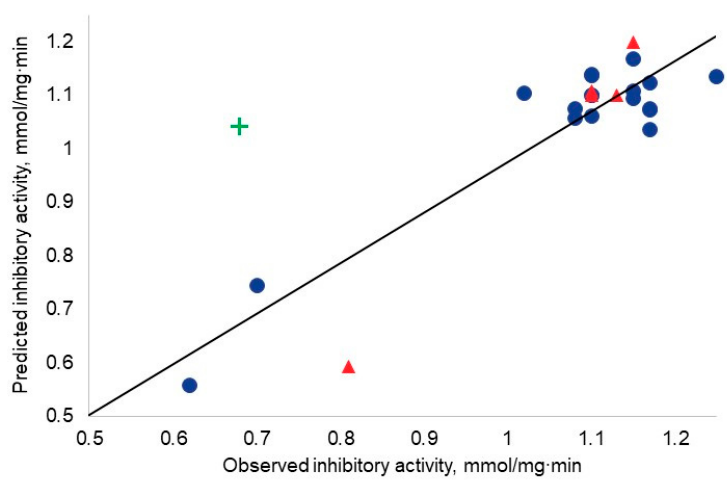
Figure 1. Observed–predicted diagram. Blue dots represent the training set; red triangles represent the test set; green cross represent the outlier.